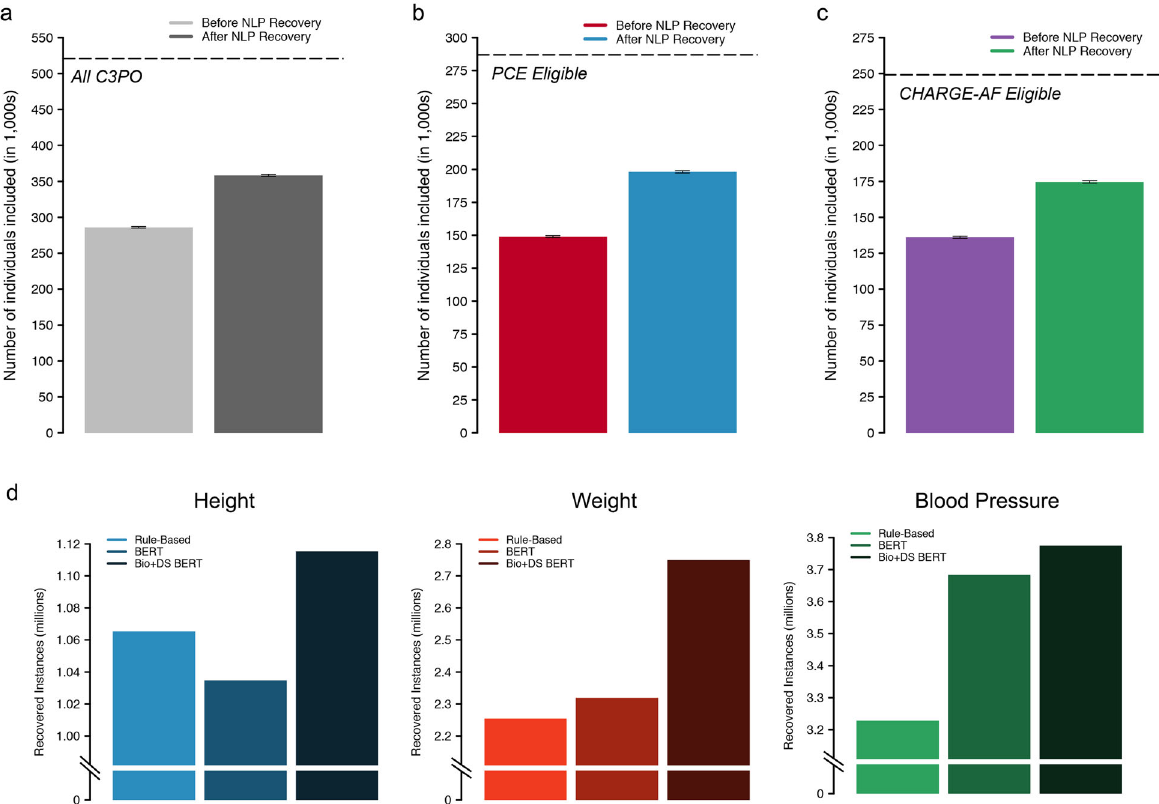
Fig. 3 Yield of NLP-based missing data recovery. Depicted is a summary of the yield of our deep natural language processing (NLP) based model for missing data recovery in C3PO. a – c Compare effective sample sizes with versus without NLP recovery, where error bars depict 95% con fi dence intervals. a The y -axis depicts the total number of individuals with a baseline height, weight, and blood pressure, and the hashed line indicates the total sample size of C3PO. b The y -axis depicts the total number of individuals with a complete Pooled Cohort Equations (PCE) score at baseline and the hashed line indicates the total number of individuals eligible for PCE analysis (i.e., within age 40 – 79 years, with available follow-up data, and without prevalent MI/stroke). c The y -axis depicts the total number of individuals with a complete CHARGE-AF score at baseline and the hashed line indicates the total number of individuals eligible for CHARGE-AF analysis (i.e., within age 45 – 94 years, with available follow-up data, and without prevalent AF). d Depicts the total number of vital sign extractions obtained using the rule-based method (light shades), BERT (medium shades), and Bio + DischargeSummaryBERT (Bio + DS BERT, dark